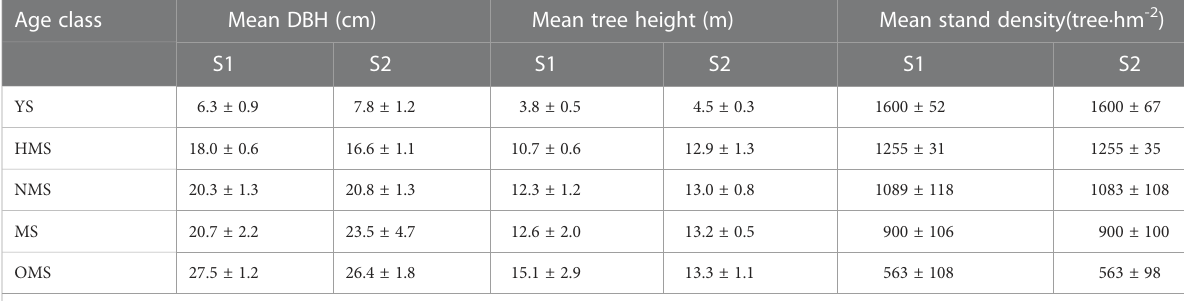
TABLE 1 Pro fi les of the sample